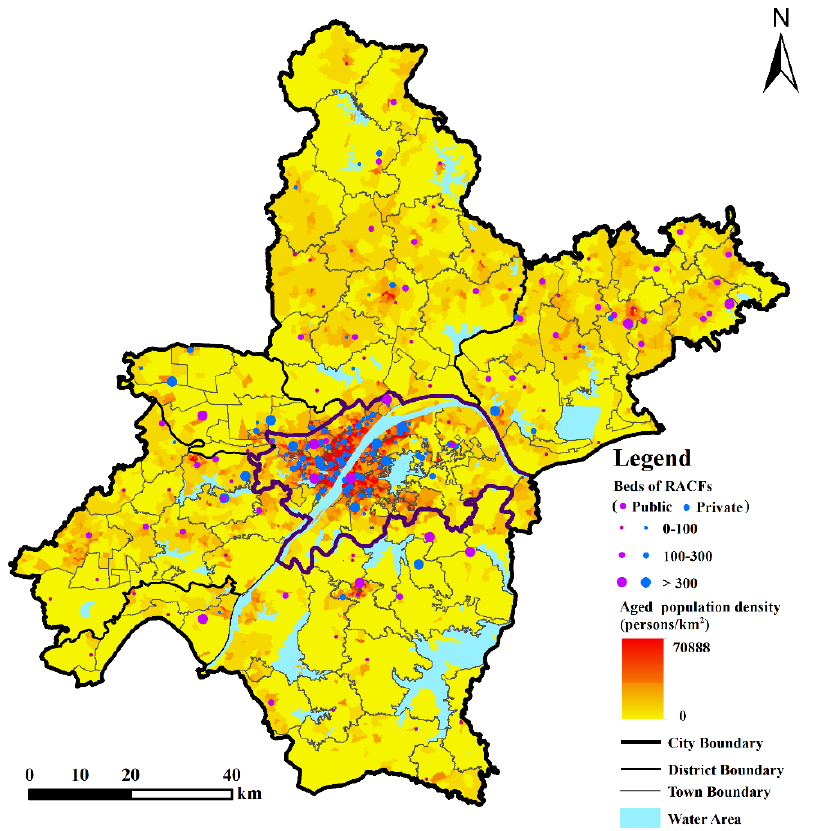
Figure 4. Spatial distribution of aged population and RACFs in Wuhan.